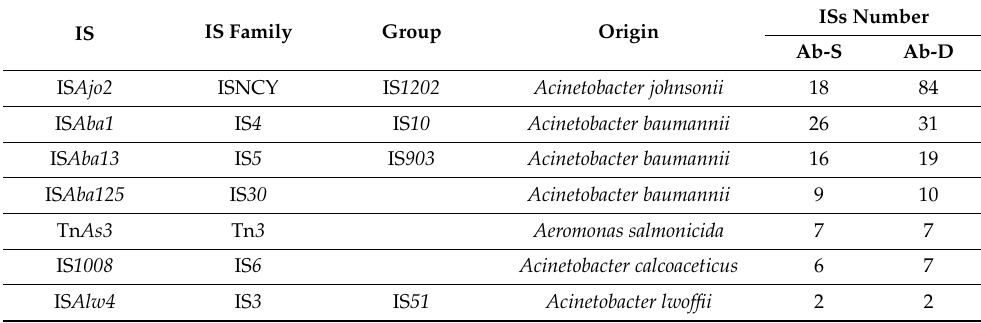
Table 4. Most abundant IS elements found by ISFinder in Ab-S and